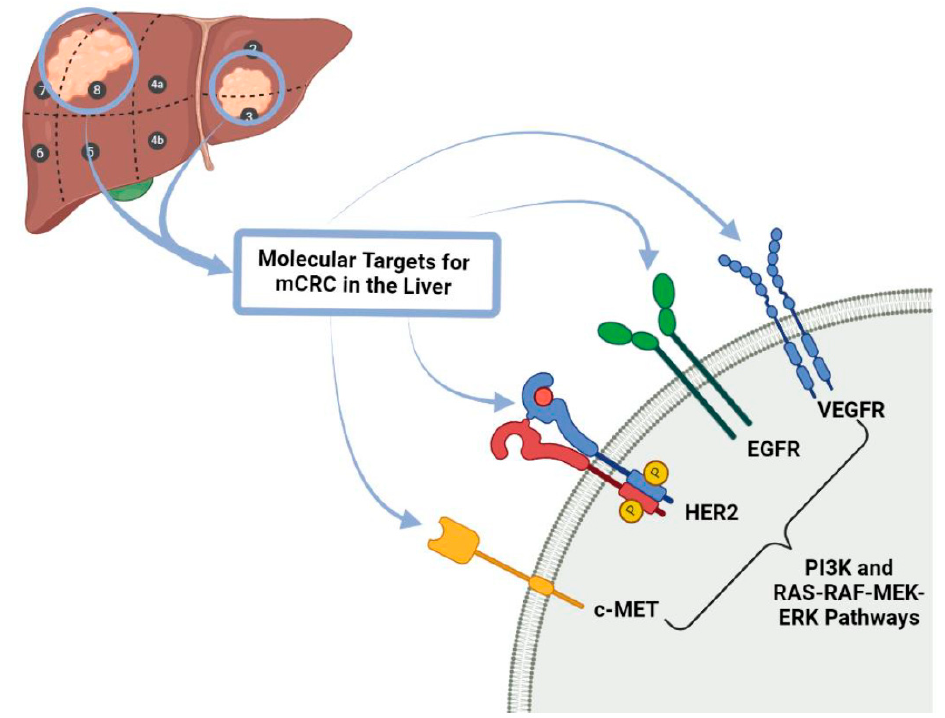
Figure 2. Molecular Targets for mCRC in the liver. c-MET: tyrosine-protein kinase Met receptor, HER 2: Human Epidermal Growth Factor Receptor-2, EGFR: Epidermal growth factor receptor, VEGFR: Vascular Endothelial Growth Factor Receptor PI3K: Phosphoinositide 3-kinase, RAS-RAF-MEK-ERK pathways also known MAPK/ERK pathway corresponds to the Ras/Raf/Mitogen-activated protein kinase/ERK kinase (MEK)/extracellular-signal-regulated kinase (ERK) cascade couples signals from cell surface receptors to transcription factors, regulating gene expression and mCRC: metastatic colorectal cancer.